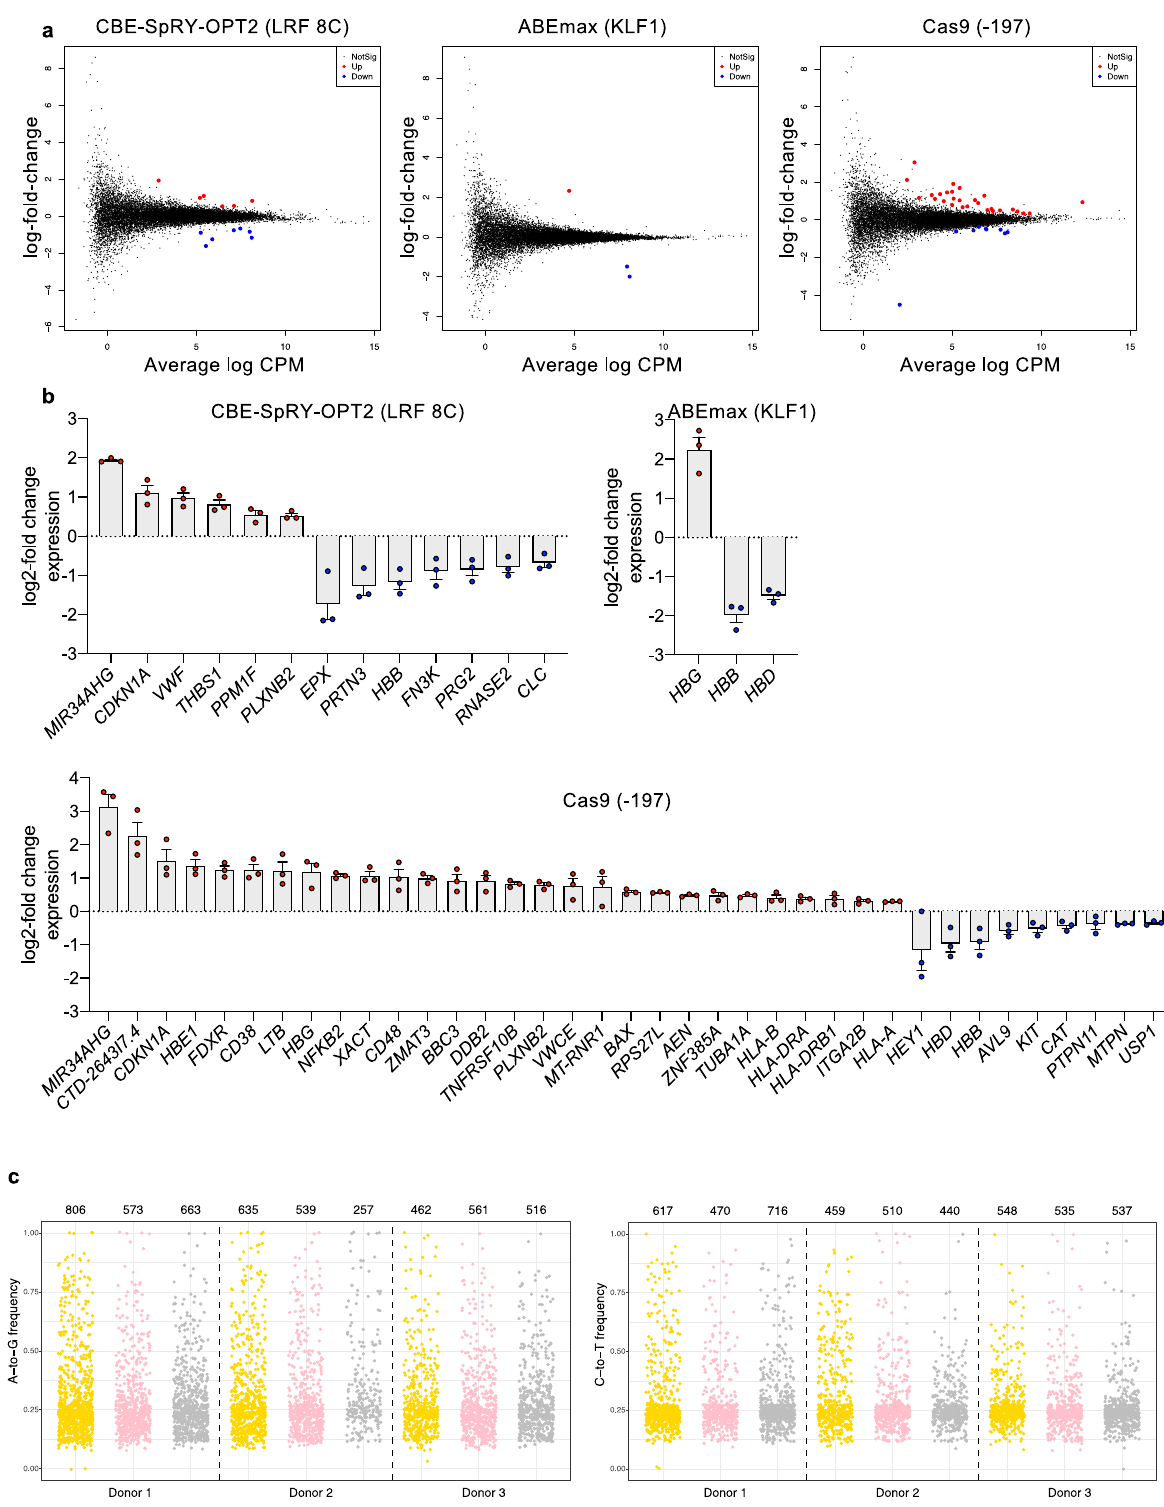
Fig. 6 | Transcriptomic analysis of HD HSPCs after RNA-mediated base editing and RNP-mediated Cas9 treatment. a RNA-seq analysis was performed 48h after transfection. Mean-difference plots show differentially expressed genes of edited samples over control samples. Genes that are not statistically signi fi cant (false dis- covery rate [FDR]>0.05) differentially expressed are depicted by black dots. Genes that are statistically signi fi cant (FDR<0.05) upregulated or downregulated are depicted by red and blue dots, respectively. The enzyme used and the pro fi le